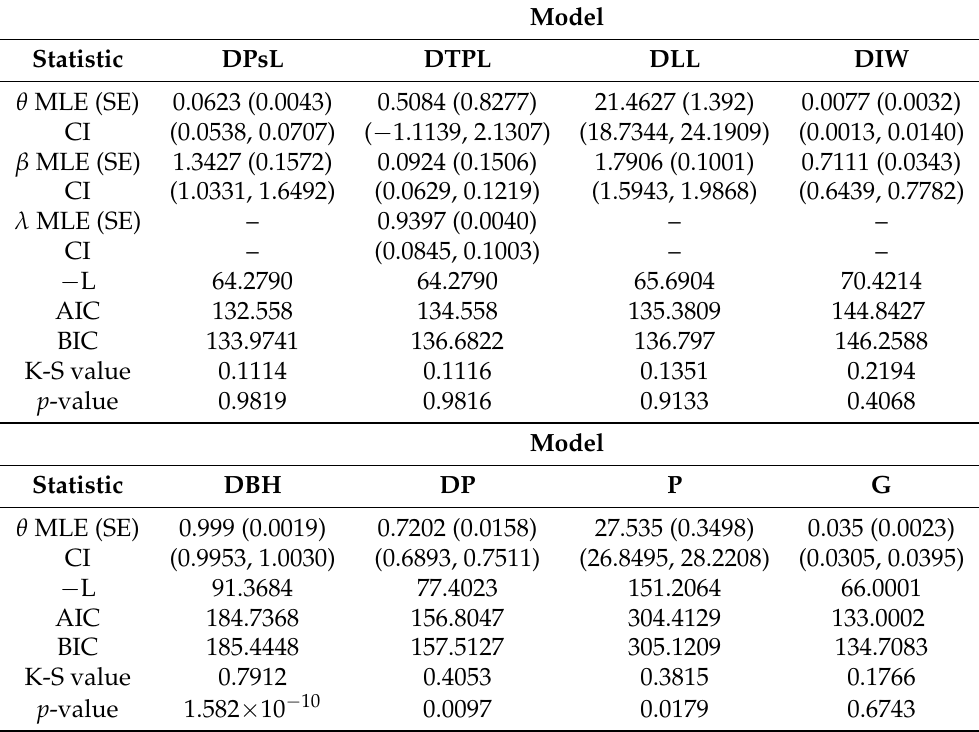
Table 9. The MLEs, CIs, − L, AIC, BIC, K-S and p -values of all the fitted distributions for the failure times